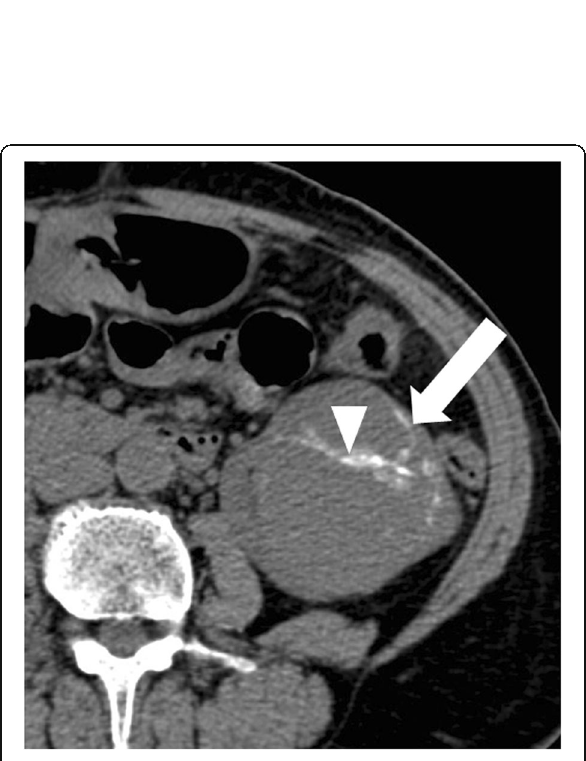
Fig. 6 Bosniak category IIF renal cyst. Axial non-enhanced CT image shows a lesion with irregular calcifications within the wall (arrow) and septa